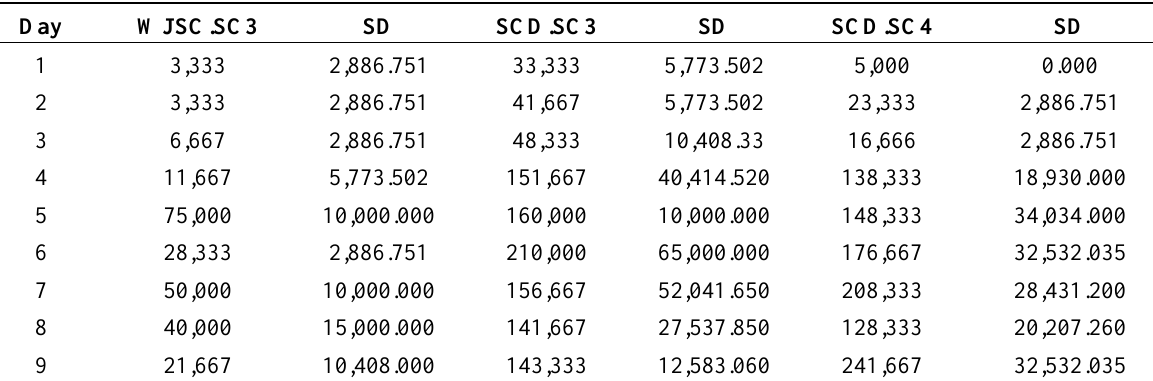
Table 1. Averaged cell count, by day, for each cell line. The standard deviation for each count is delineated by the SD columns.